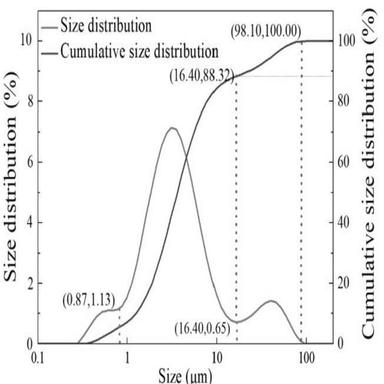
Particle size distribution of the SCFD used in the tests.